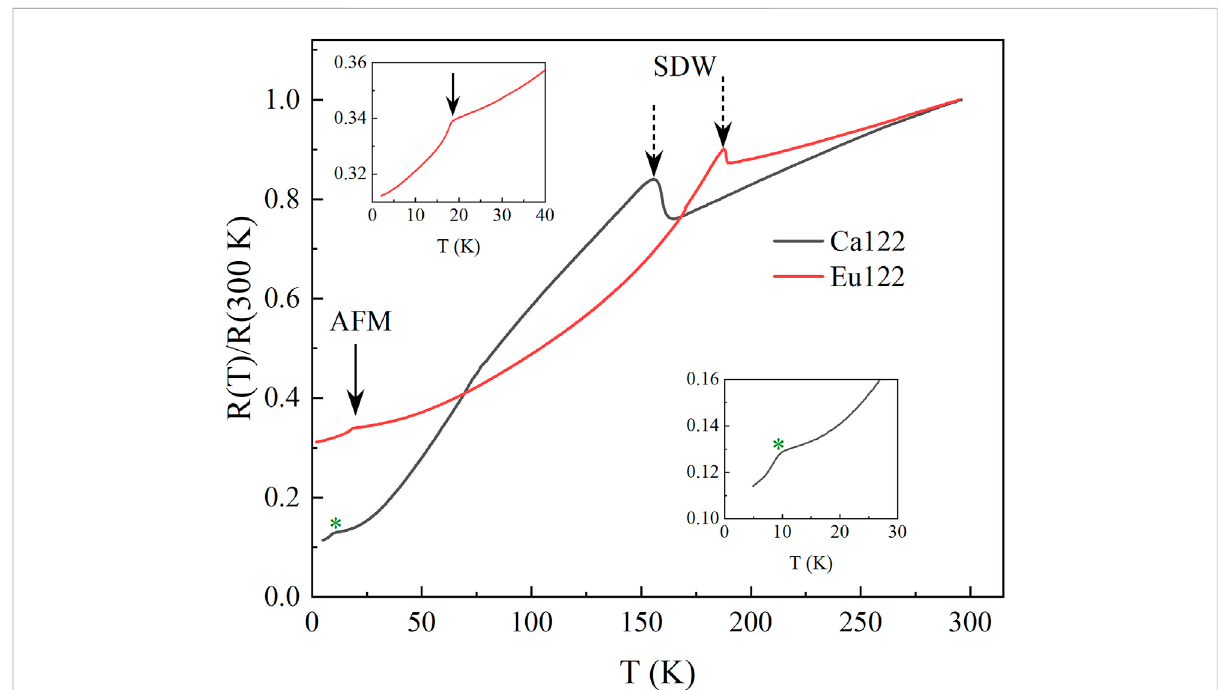
FIGURE 1 ElectricalResistance.Normalizedelectricalresistancevs.temperatureforCa122andEu122.Bothsamplesshowaclearanomaly,near160 Kand 190 K for Ca122 and Eu122, respectively, and indicated by dashed arrows, that arises due the SDW transition. The tiny kink near 19 K for Eu122, as indicatedbythesolidarrow,isduetotheEu 2+ AFMorder.Asmalldrop inresistanceforCa122near10 K,asdenoted byan asterisk,islikelyduetothe superconducting transition (see the text). Upper inset: magni fi ed view of the Eu 2+ AFM transition in Eu122. Lower inset: magni fi ed view of the low-temperature drop in resistance for